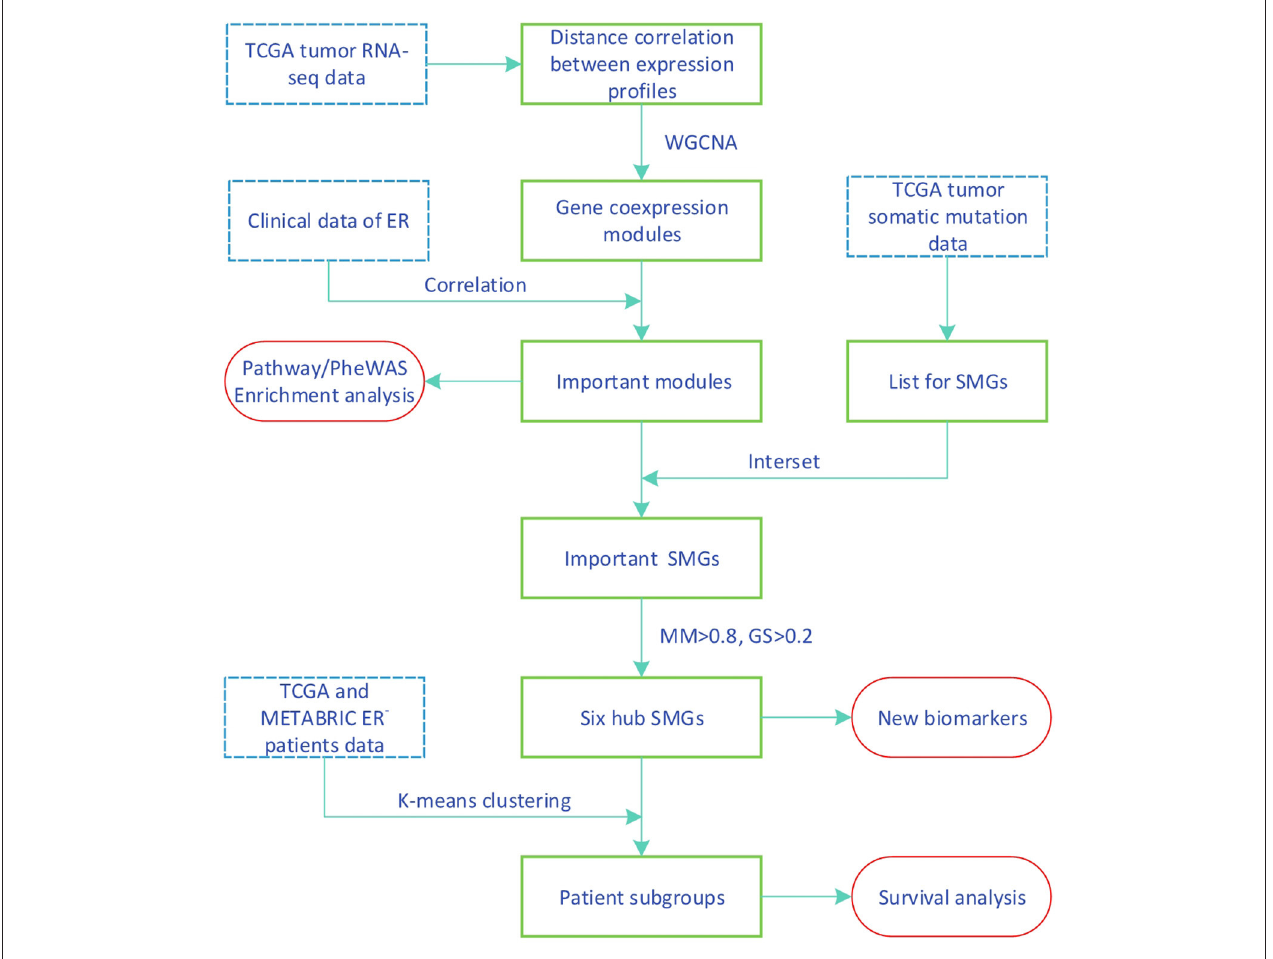
FIGURE 1 | Workflow of identifying new biomarkers using transcriptomic and variants data.